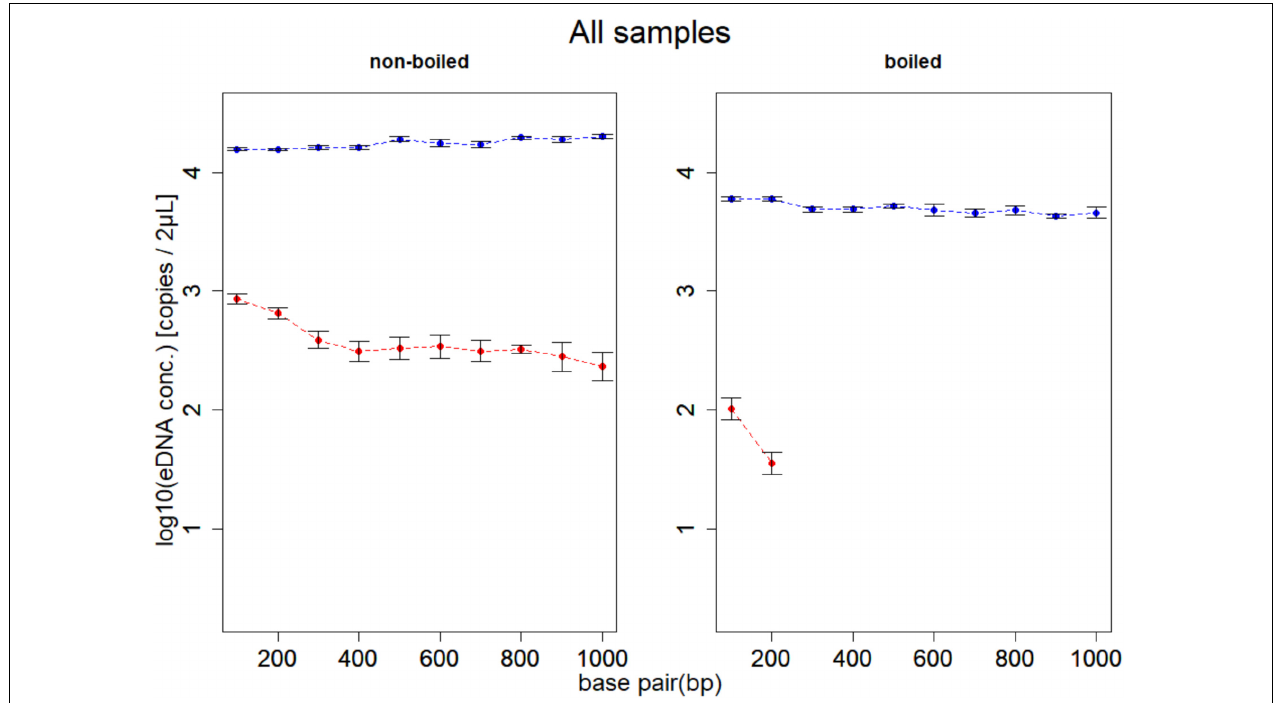
FIGURE 3 | Results of experiment 1. Mean eDNA copy number of samples for boiling and PMA treatments at each of 10 target sequence lengths (132, 225, 333, 440, 529, 621, 715, 832, 935, and 1,021 bp). The left panel shows the non-boiled samples, and the right panel shows the boiled samples. Dashed lines show change in total eDNA copy number (blue; non-PMA) and intracellular eDNA copy number (red; PMA). The total eDNA copy number (blue line) did not change even if the target sequence length increased, and the intracellular eDNA (red line) tended to decrease as the target sequence length increased. In addition, no eDNA above 333 bp was detected in the boiled PMA sample. The effects of the boiling treatment are found on both total and intracellular eDNA, but intracellular eDNA is more significantly affected. TABLE 4 | Results of MANOVA (upper) and post hoc test (lower) for the relationships between eDNA copy numbers at each treatment (PMA/intracellular eDNA vs. non-PMA/total eDNA) and each factor (days and assay length). MANOVA